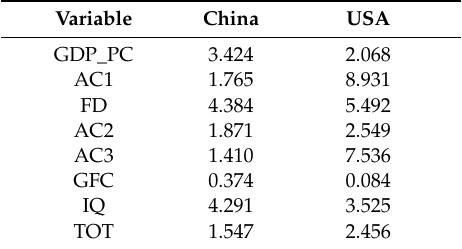
Table A3. Variance inflation factors for China and USA.